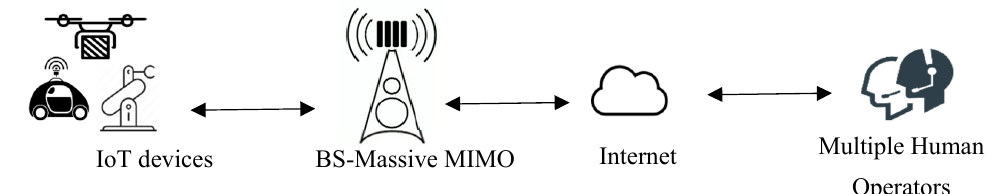
Figure 8. Basic IoT operation over tactile internet on massive multiple-input multiple-output (MIMO).